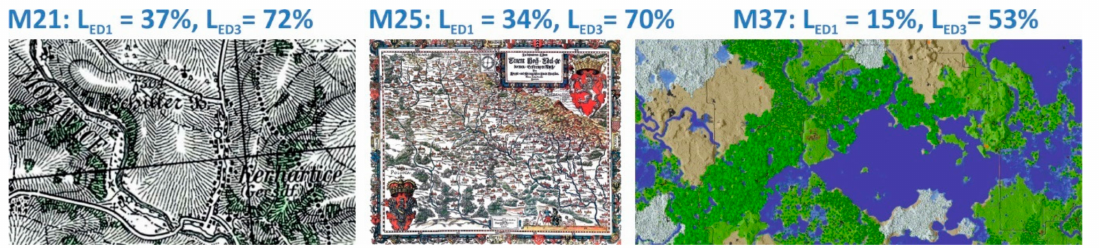
Figure 14. Maps M21 and M25 with the highest L ED values and